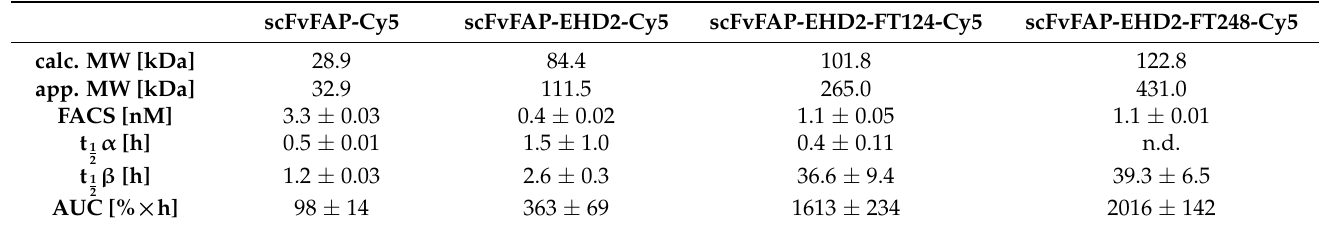
Table 4. Biochemical, binding, and pharmacokinetic properties of scFv-EHD2-Cy5-based molecules. Mean ± SD, n.d.: not determined, n =